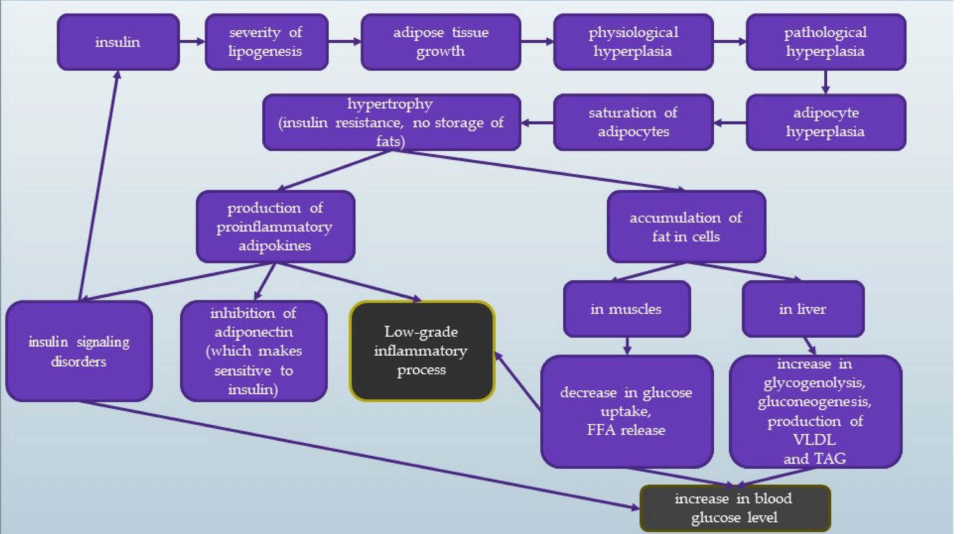
Figure 3. Mechanism of insulin resistance. (FFA—free fatty acids; TAG—triglycerides; VLDL—very- low-density